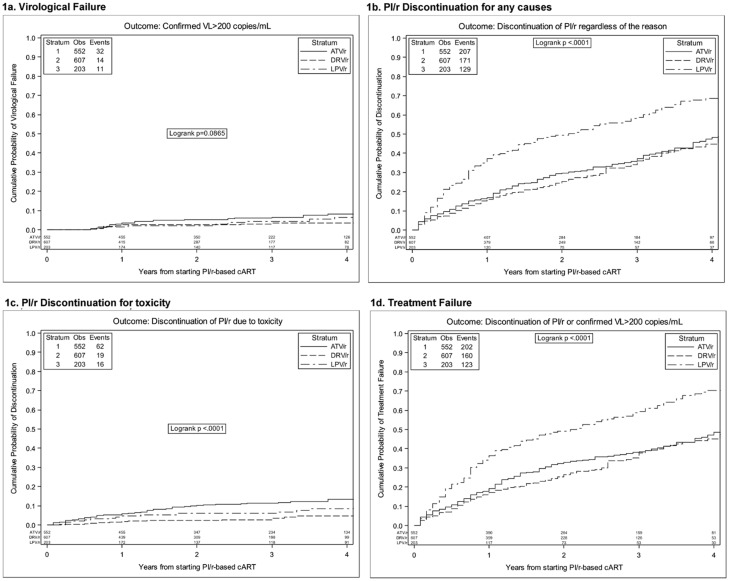
Kaplan Meier curves of the probability of reaching the different end-points according to the PI/r component of the initial cART regimen in 1362 HIV positive LC patients.